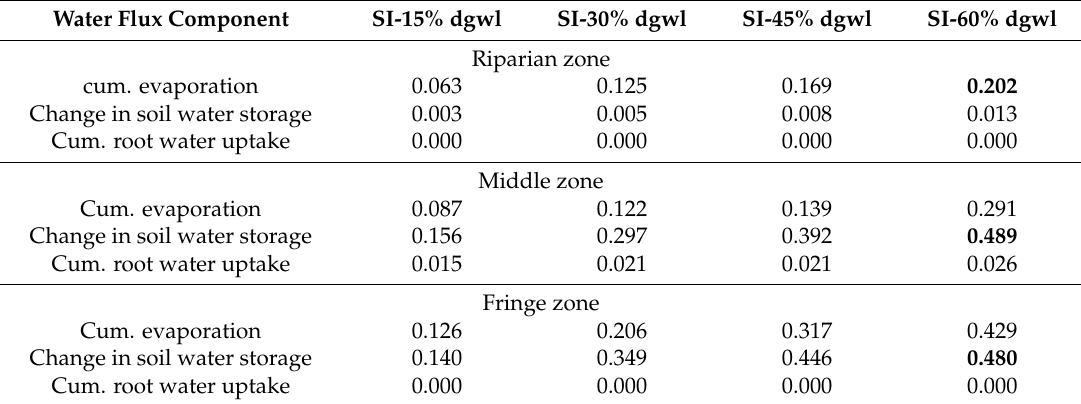
Table 12. Sensitivity indices (SI) for different water fluxes calculated after changes in the dgwl.